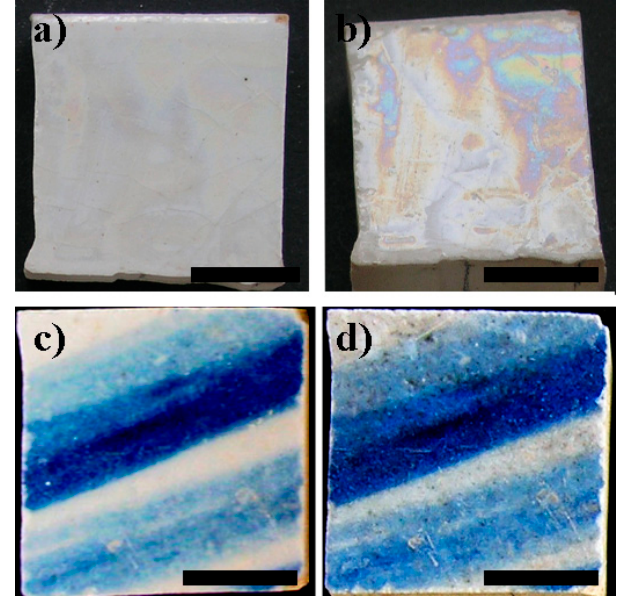
Figure 7. Aesthetical interference of the TiO 2 coating. ( a ) Sample 3TS photographed from a straight angle (90°); ( b ) Iridescent of the TiO 2 coating applied on tile sample 3TS observed from an oblique angle. Tile 1BW ( c ) before TiO 2 and ( d ) staining and darkening of the surface after the application of TiO 2 coating. Scale bars: 1 cm.